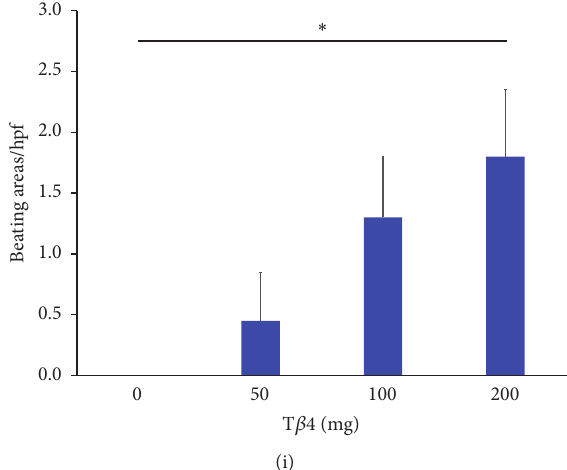
Figure 1: Thymosin 𝛽 4 promotes the generation of cardiomyocytes from murine induced pluripotent stem cells. (a) Undifferentiated iPSCs weretreatedwithT 𝛽 4-peptideandexpressionoftranscriptionfactorencodingmRNAswasmeasured4(Eomes,Brachyury(T)),6(Mesp1),or 8 (NKX-2.5) days after T 𝛽 4 treatment (red). In another approach, murine iPSCs were differentiated for 6 days and treated with T 𝛽 4-peptide. 8 days after T 𝛽 4 treatment, expression levels of cardiomyocyte markers (ANF, CX43) were measured and flow cytometric assessment of cardiac specific proteins ( 𝛼 MHC, Troponin, and 𝛼 -actinin) was performed. Furthermore, the amount of beating areas was measured (blue). (b–g) Relative expression levels of transcripts as indicated ((b–e) without prior differentiation of iPSCs, (f and g) with 6 days of prior differentiation), measured via quantitative real-time PCR, reveal that T 𝛽 4 induces the expression of transcription factors regulating the differentiation of stem cells to cardiomyocytes via mesenchymal and cardiac progenitor stages and the expression of cardiac specific transcripts. (h) Flow cytometry after intracellular staining for 𝛼 MHC, Troponin, and 𝛼 -actinin reveals the increased presence of these cardiac specific proteins after T 𝛽 4 stimulation. (i) T 𝛽 4 treated iPSCs show a high rate of spontaneous beating compared to untreated iPSCs in which beating was virtually absent. ( 𝑛 = 3 , ∗ 𝑝 < 0.05